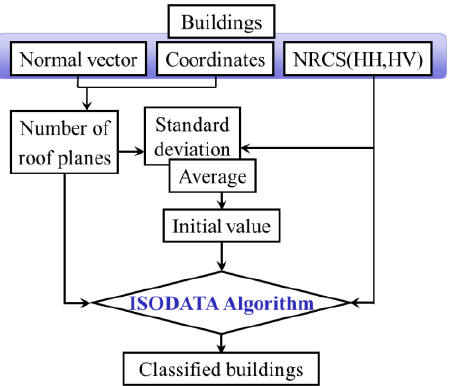
Figure 4. Process flow of building classification